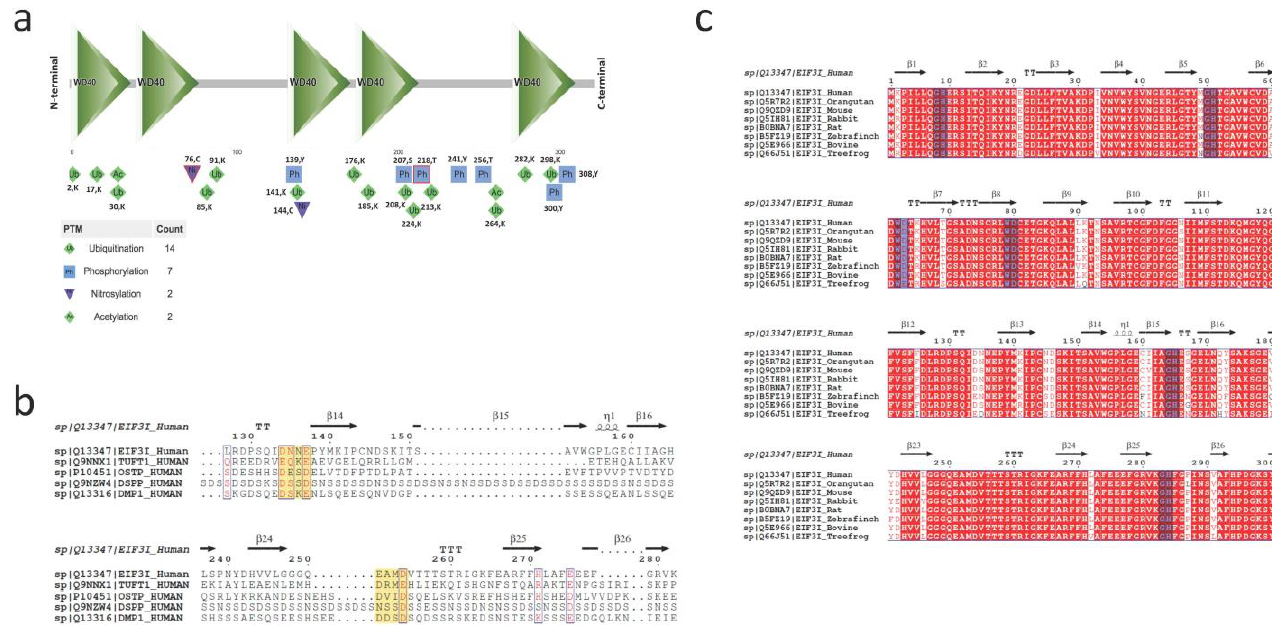
Figure 2. Functional domains and PTM sites present in TRIP-1. ( a ) The conserved domain search in the sequence of TRIP-1 using the SMART tool. Possible post-translational modifications (PTMs) are denoted in different colors and symbols. The number of PTMs is represented beneath the dia- grammatic representation of the protein. The complete list of phosphorylation sites from PhosphoSite Plus ® is provided in Supplementary Table S2. ( b ) Sequence alignment of human EIF3i with other mineralization proteins. ( c ) Sequence alignment of conserved regions of EIF3i of different animals.